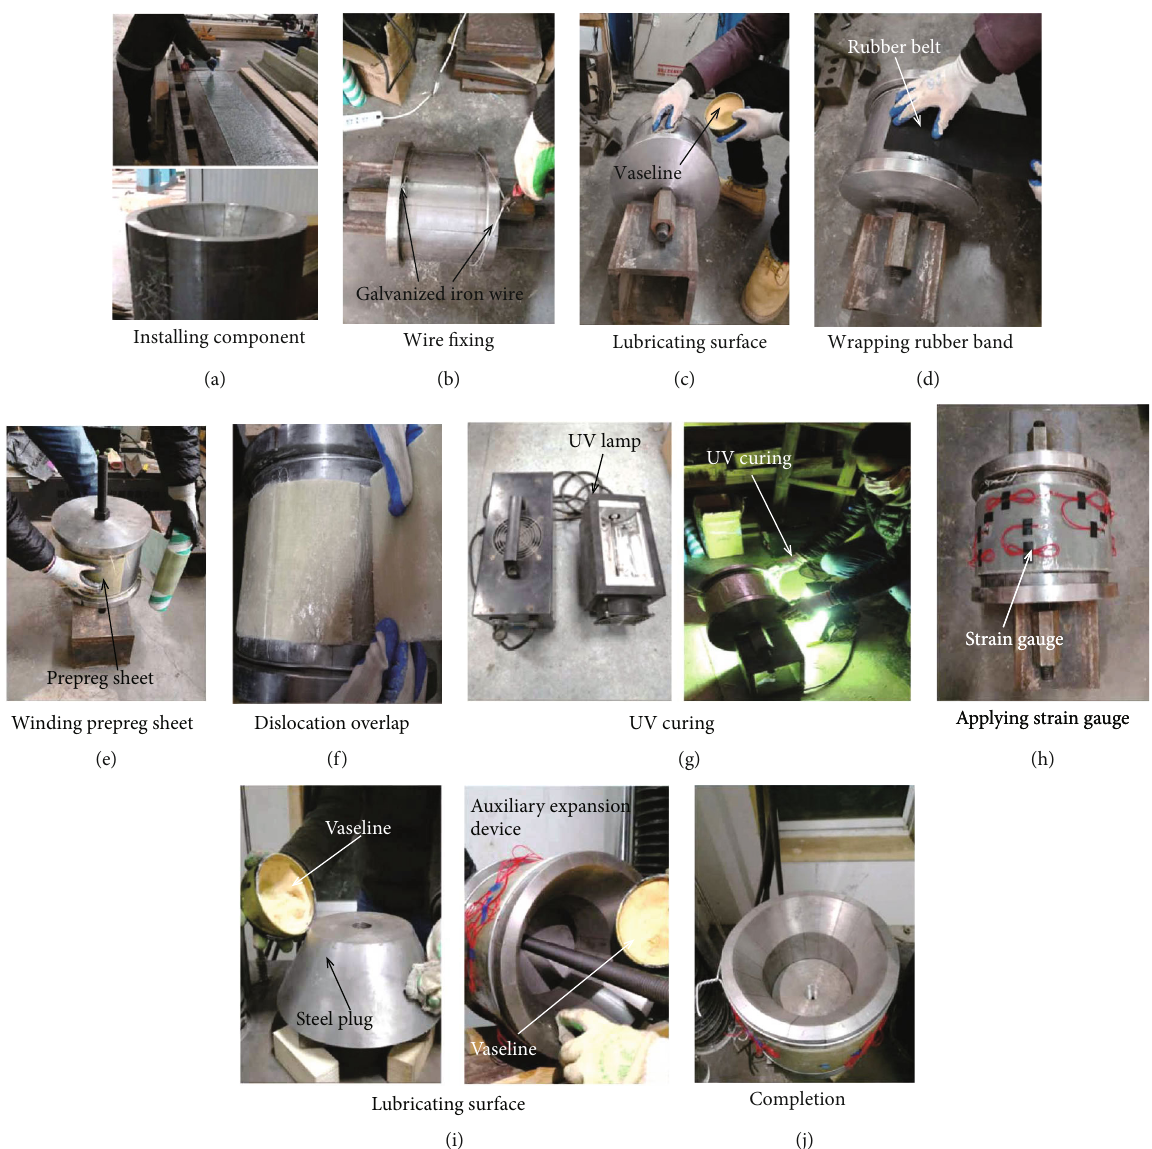
Figure 8: The manufacturing process of the specimen: (a) installing component, (b) wire fi xing, (c) lubricating surface, (d) wrapping rubber band, (e) winding prepreg sheet, (f) dislocation overlap, (g) UV curing, (h) applying strain gauge, (i) lubricating surface, and (j)